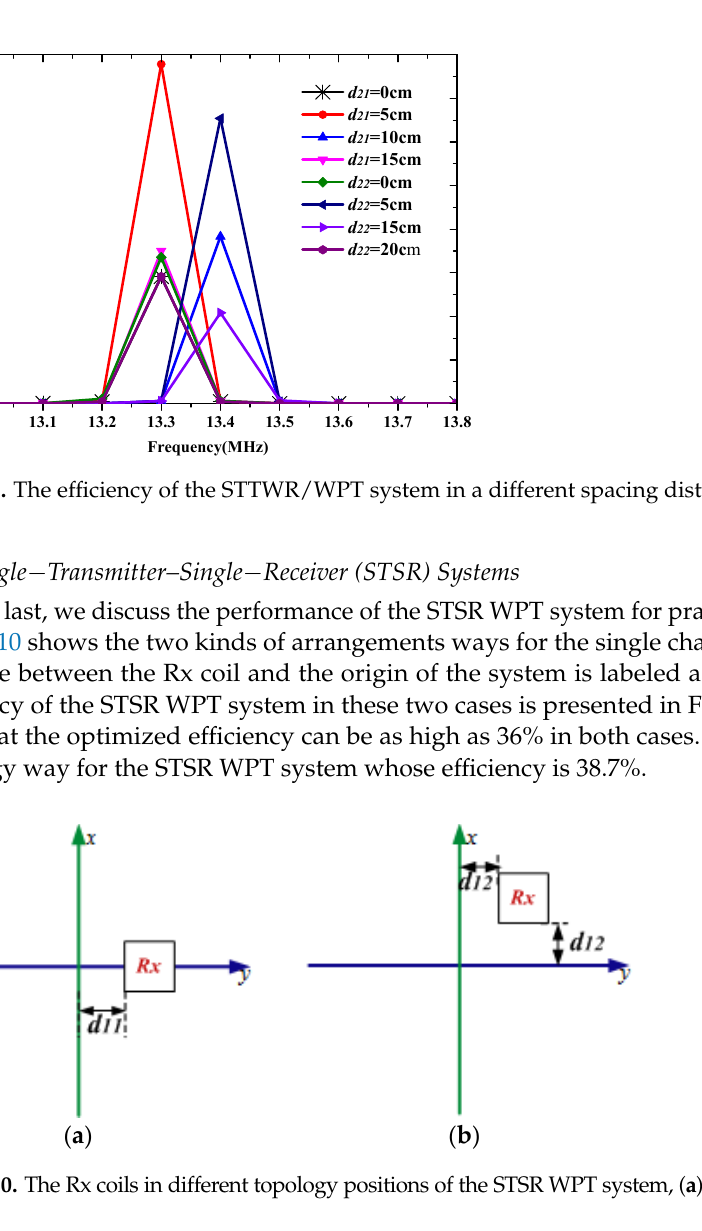
( b ) Figure 11. The efficiency of the STSR WPT system in different cases, ( a ) case5 and ( b ) case 6.